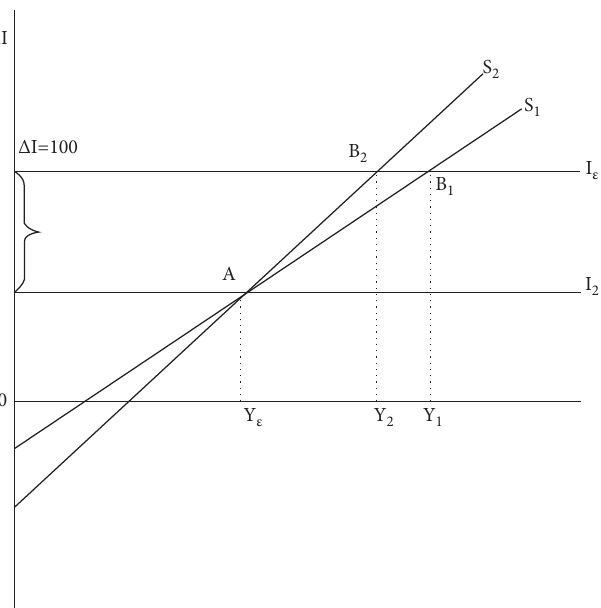
Figure 3: The equilibrium between the savings function curve and the investment curve.